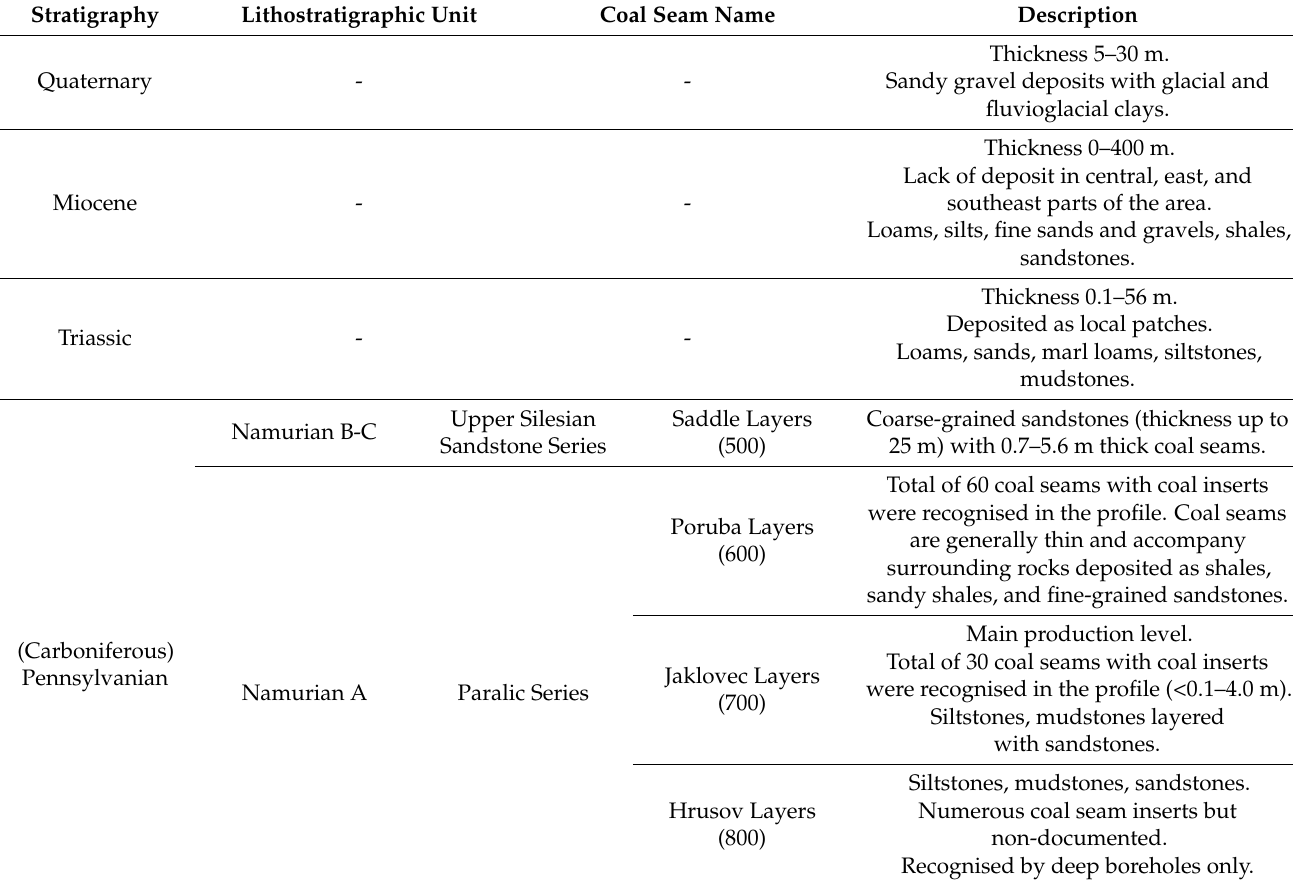
Table 1. Summarised lithological description of Rydułtowy 1 coal deposit (Rydułtowy mine archive